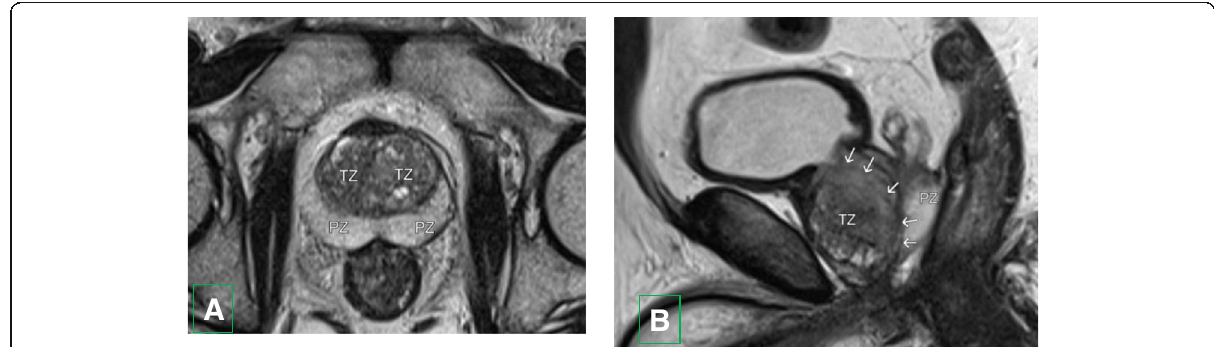
Fig. 4 Sixty-two years old man with type 1 BPH. a Axial T2 WI showing bilateral transition zone (TZ) enlargement. Peripheral zone (PZ) is noted. b Sagittal T2 WI showing transition zone (TZ) enlargement displacing the prostatic urethra posteriorly (arrows). No retrourethral enlargement. Peripheral zone (PZ) is